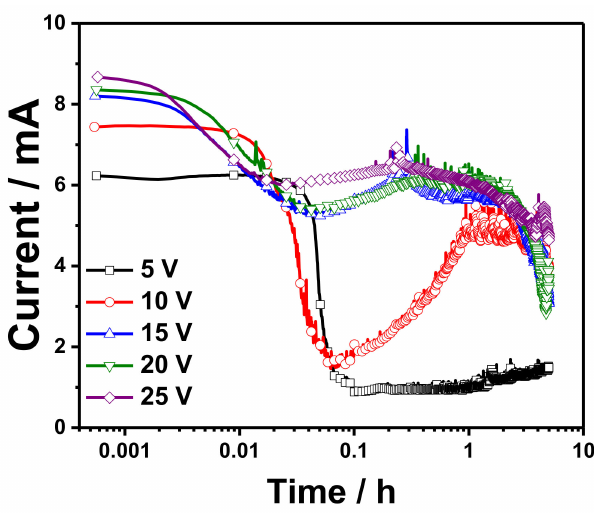
Figure 1. Current-time curves recorded during the anodization of copper foam in 0.1 M K 2 CO 3 at 5, 10, 15, 20, 25, and 25